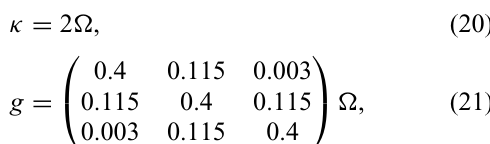
FIG. 4. Atomic dynamics in a lossy multimode cavity. (a) Sketch of a possible setup corresponding to Hamiltonian (18) and param- eters (19), where three clusters of atoms are trapped in a plane transverse to the cavity axis and interact with cavity modes localized around the different clusters. Such spatial-dependent intensity profiles could be obtained in a confocal cavity QED [ 23,25]. We assume that each cavity mode can be monitored independently. Panels (b), (c), and (d) respectively show the mean entropy, the mutual infor- mation, and the negativity of the combined state of atomic clusters 1 and 3 depending on which modes of the cavity are continuously monitored via homodyning. The results are obtained from integrating 3000 samples of the conditioned HEOM (17) with parameters (19)–(21) and N atoms =